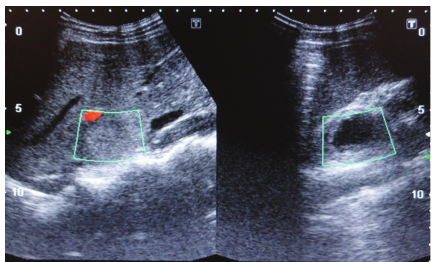
Figure 3: Ultrasound of abdomen showing heterogeneous lesions at the upper poles of both kidneys suggestive of bilateral adrenal masses.